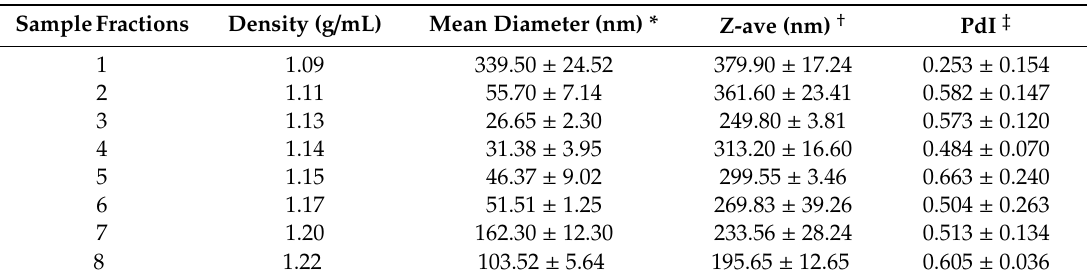
Table 1. Dynamic light scattering (DLS) analysis of vesicles in density fractions of bronchoalveolar lavage (BAL)